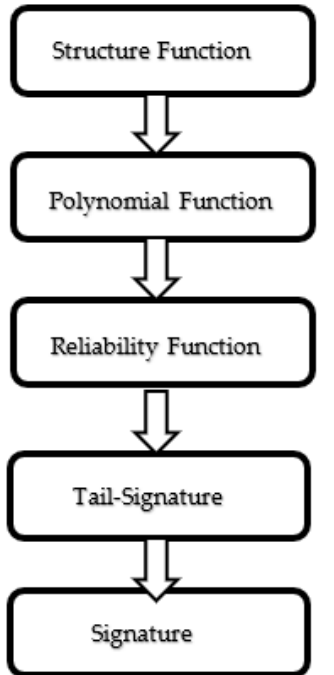
Figure 1. Flow chart diagram to determine the signature.